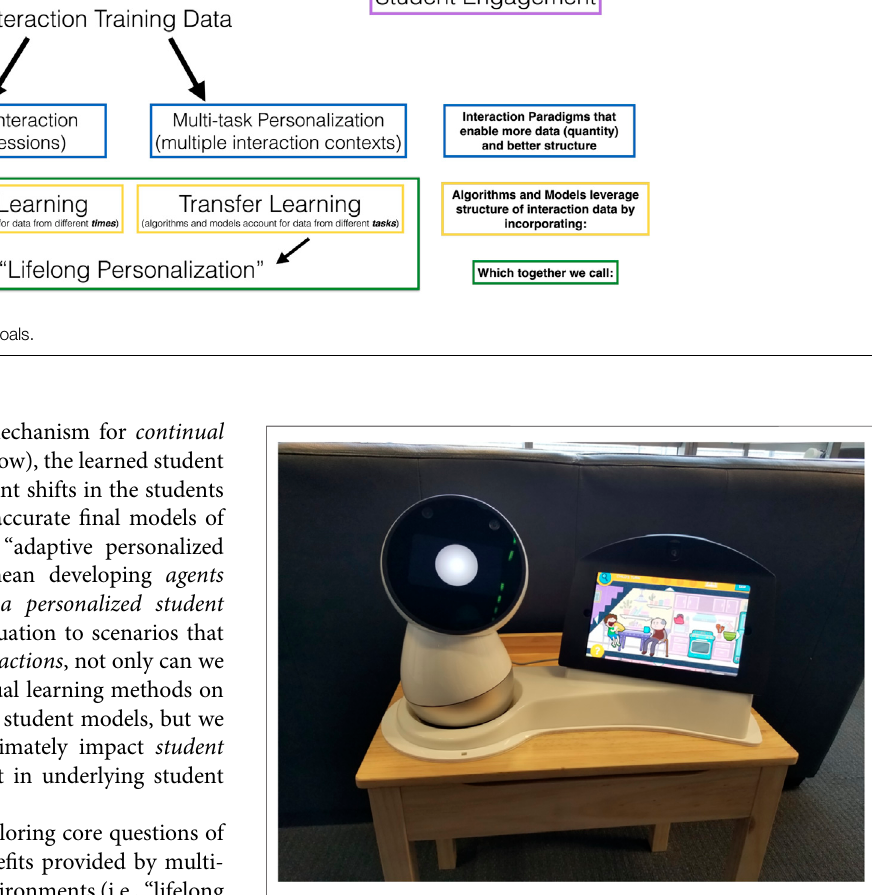
FIGURE 2 | An integrated social robot platform that supports different game “ tasks.